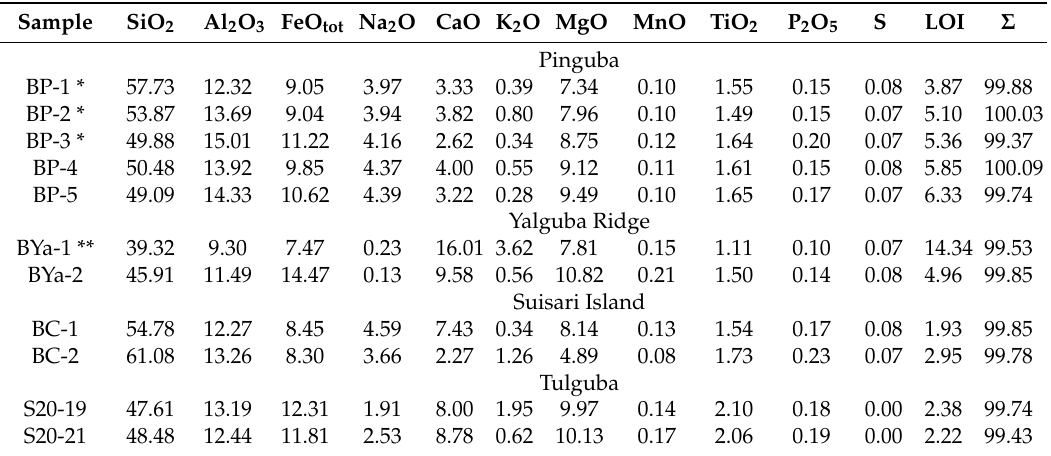
Table 1. Chemical composition of agate-bearing volcanics from the LSH, Onega Basin, wt%.